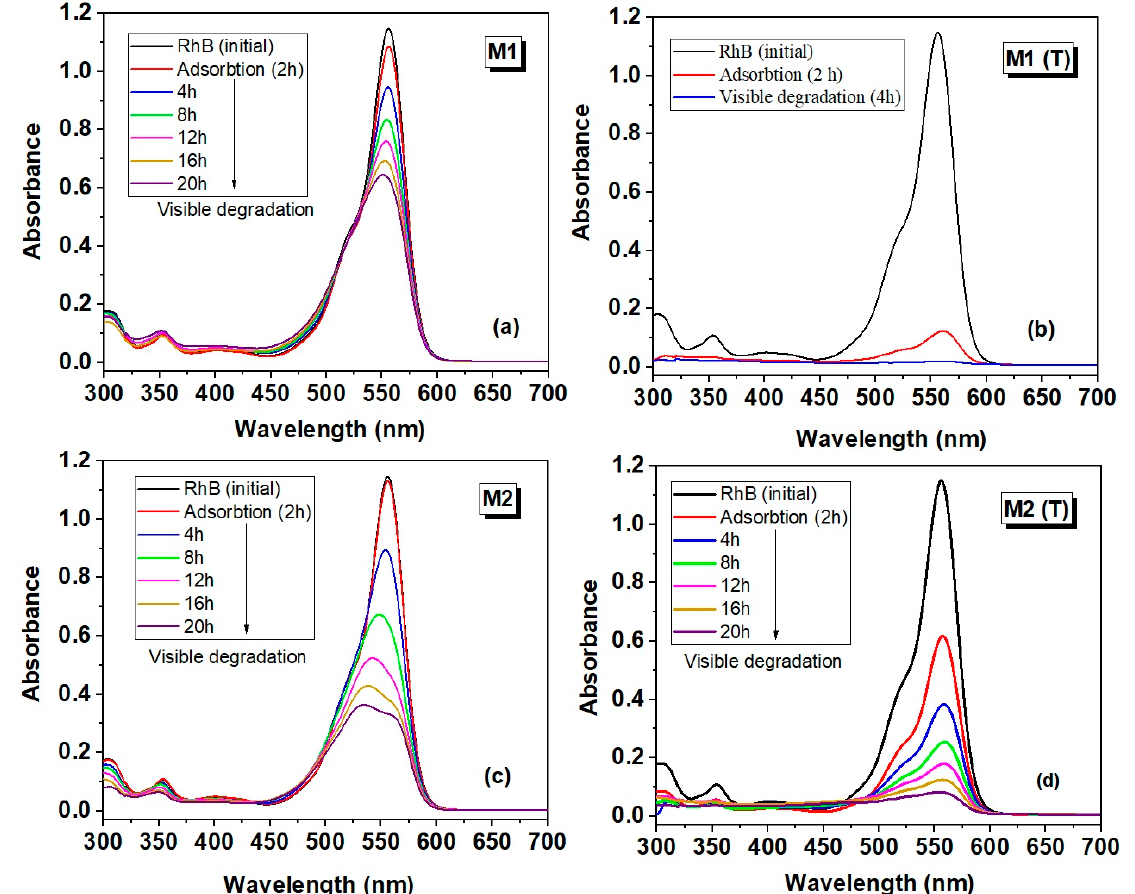
Figure 8. UV–Vis absorption spectra of Rhodamine B (RhB) recorded after adsorption (2h) (in dark) and photodegradation process under visible light irradiation (up to 20 h) for the materials obtained by dipping method ( M1 , M1 ( T )) and hydrothermal method ( M2 , M2 ( T )): ( a , c ) before calcination and ( b , d ) after calcination.